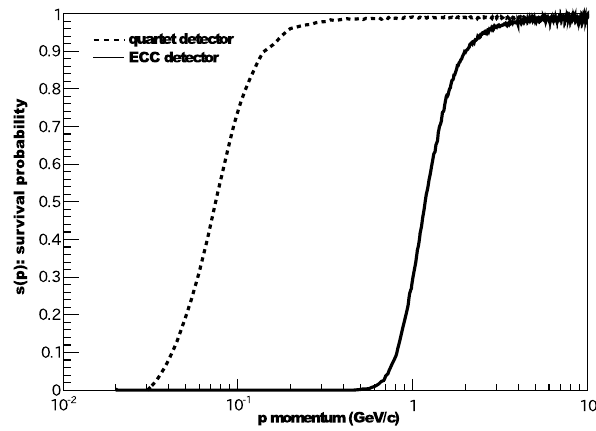
Fig. 9. Momentum dependence of the efficiency for the ECC detec- tor (solid line) and quartet detector (dashed